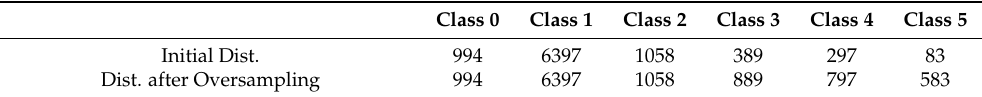
Table 3. Initial distributions of the 6 classes of house prices and their corresponding distributions after the application of SMOTE for